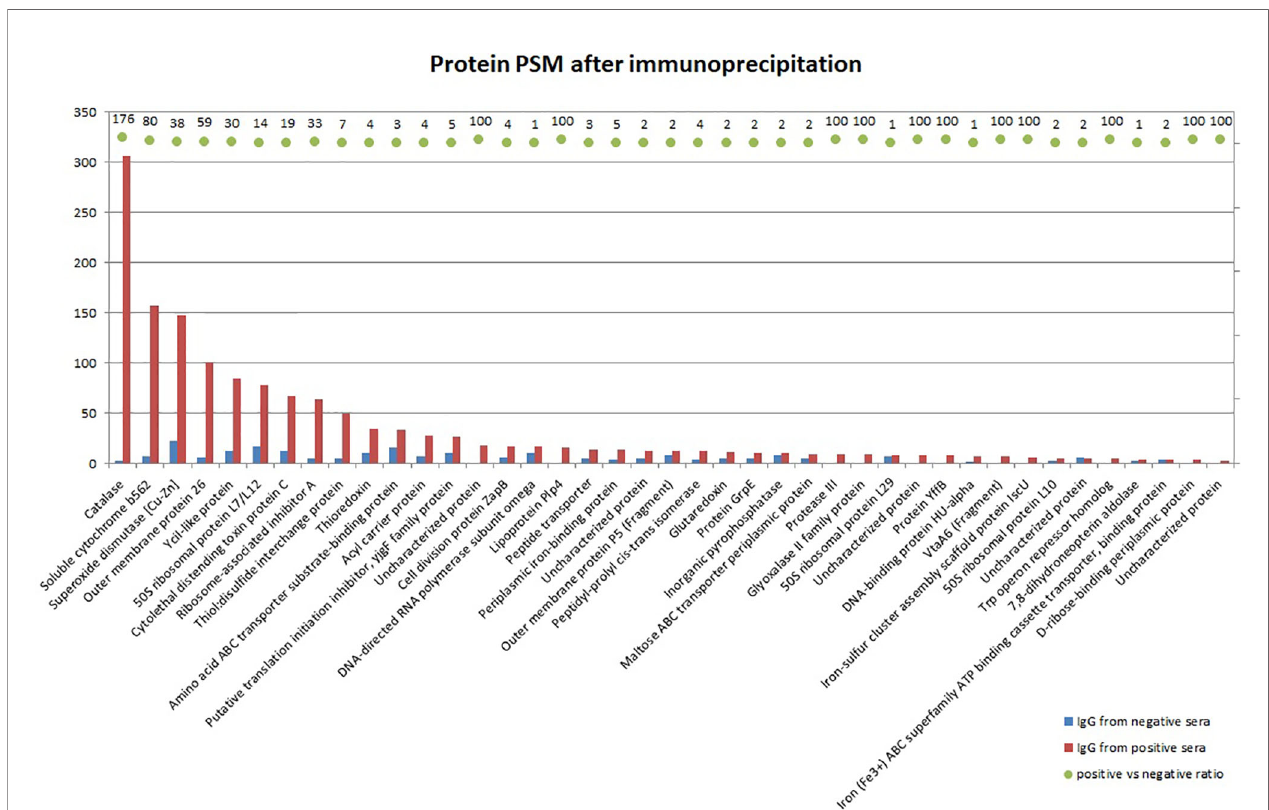
FIGURE 3 | Mass spectrometry analysis of bacterial proteins from the crude capsular extract precipitated with IgG antibodies isolated from positive or negative pooled serum. Bars in the graph show identi fi ed protein quantity by PSM (peptide spectrum match), whereas the ratio between positive and negative sera is expressed by AUC (area under the curve) for each corresponding protein. The ratio which equals 100 is maximum de fi ned value meaning that the protein is not detected in negative sera at all.